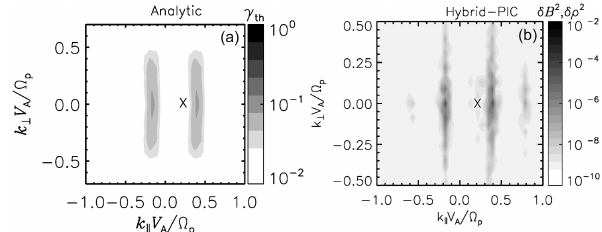
Figure 3. Comparison between the extended map of the growth rates in the k (cid:107) − k ⊥ wavenumber domain (a) and 2-D wavenumber spectrum of density and magnetic field field fluctuations (b) from Comi¸sel et al. (2019). The location of Alfvén pump waves is marked by a cross